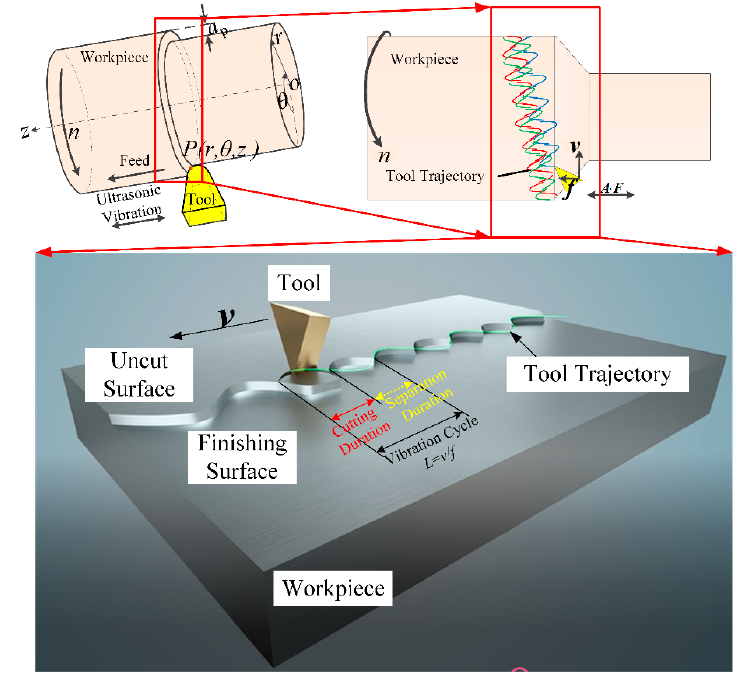
Figure 3. Schematics of the “snake-type” vibration cutting (SVC, snake-type vibration cutting) method.